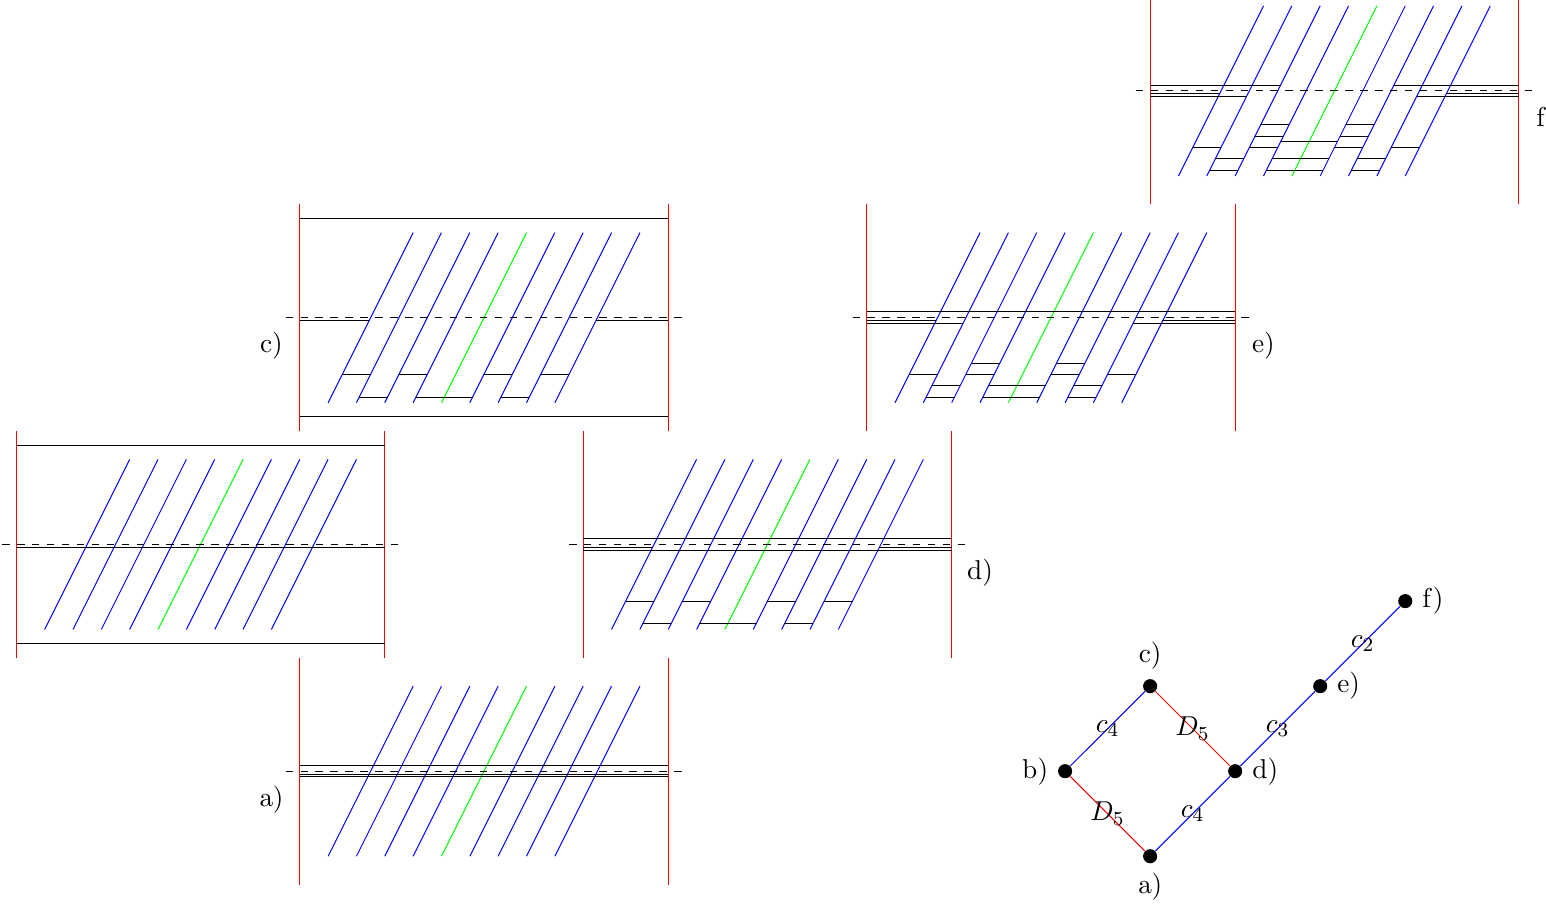
Figure 7 . Different phases of the brane set up for O (3) with 4 fundamental hypermultiplets, and the Hasse diagram which can be read from the brane systems. The green line represents an O 5 + orientifold plane parallel to the D5